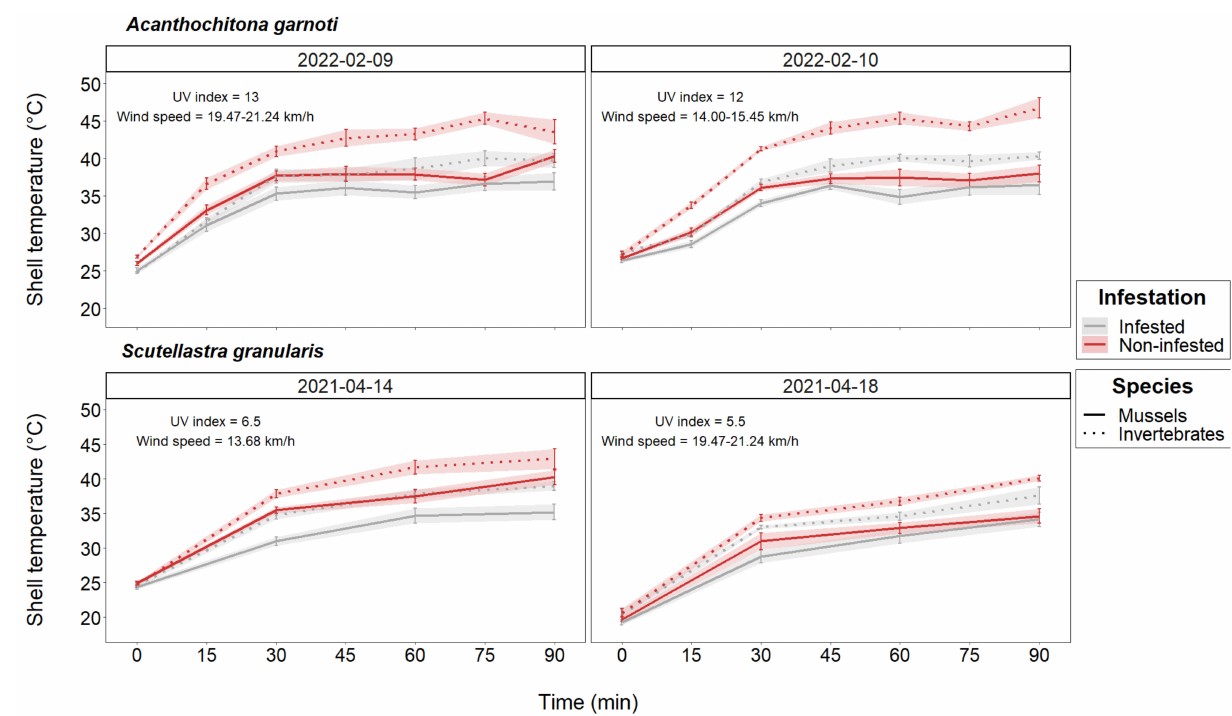
Figure 2. Changes in mean ( ± SE) shell temperatures (in ◦ C) of the chiton ( Acanthochitona garnoti ) and the limpet ( Scutellastra granularis ), with the corresponding biomimetic mussels ( Perna perna ), in either infested or non-infested mussel beds ( n = 3) for 90 min after emersion, on each corresponding experimental